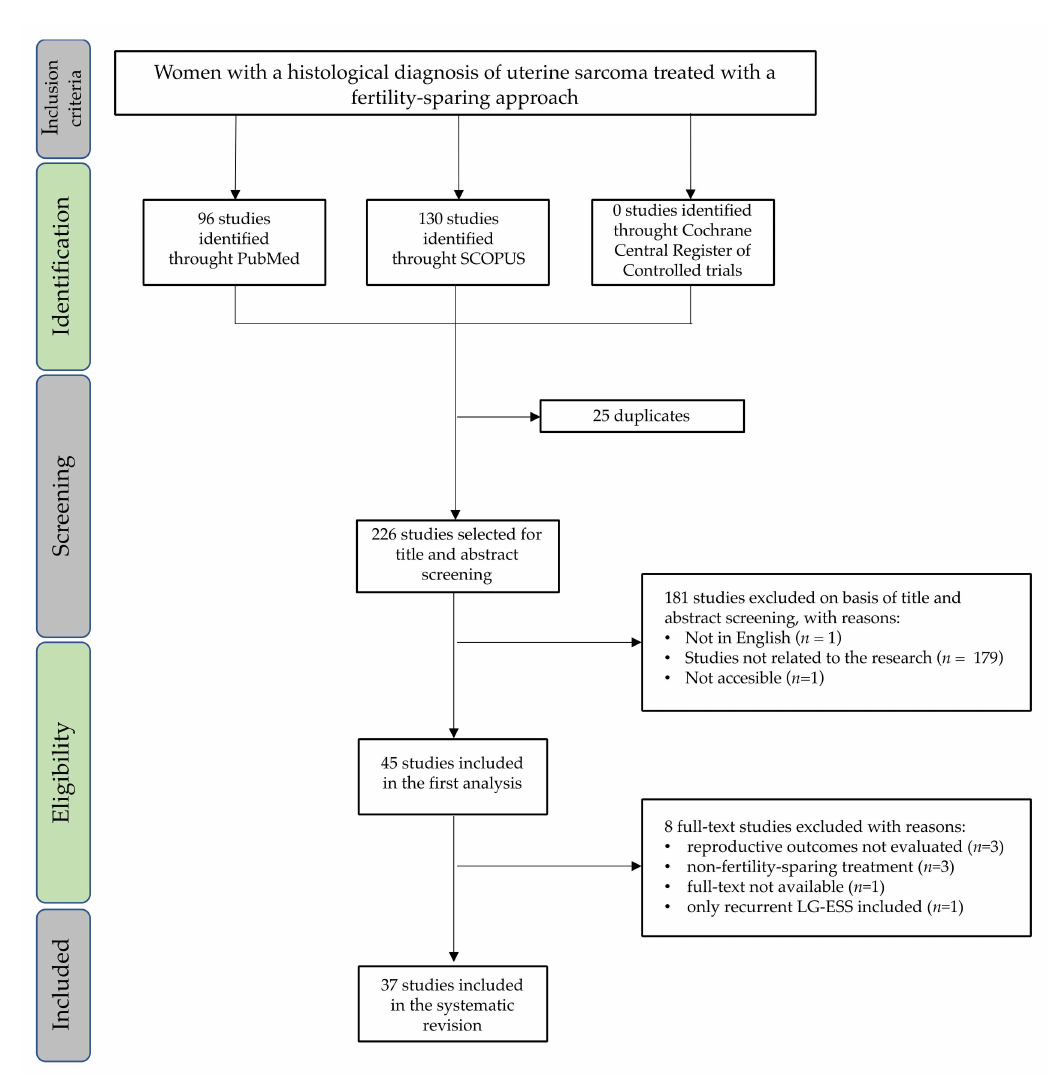
Figure 1. PRISMA flow chart for the studies included in the systematic review. LG-ESS: low-grade endometrial stromal sarcoma. Table 1. Quality assessment tool for the observational cohort and cross-sectional